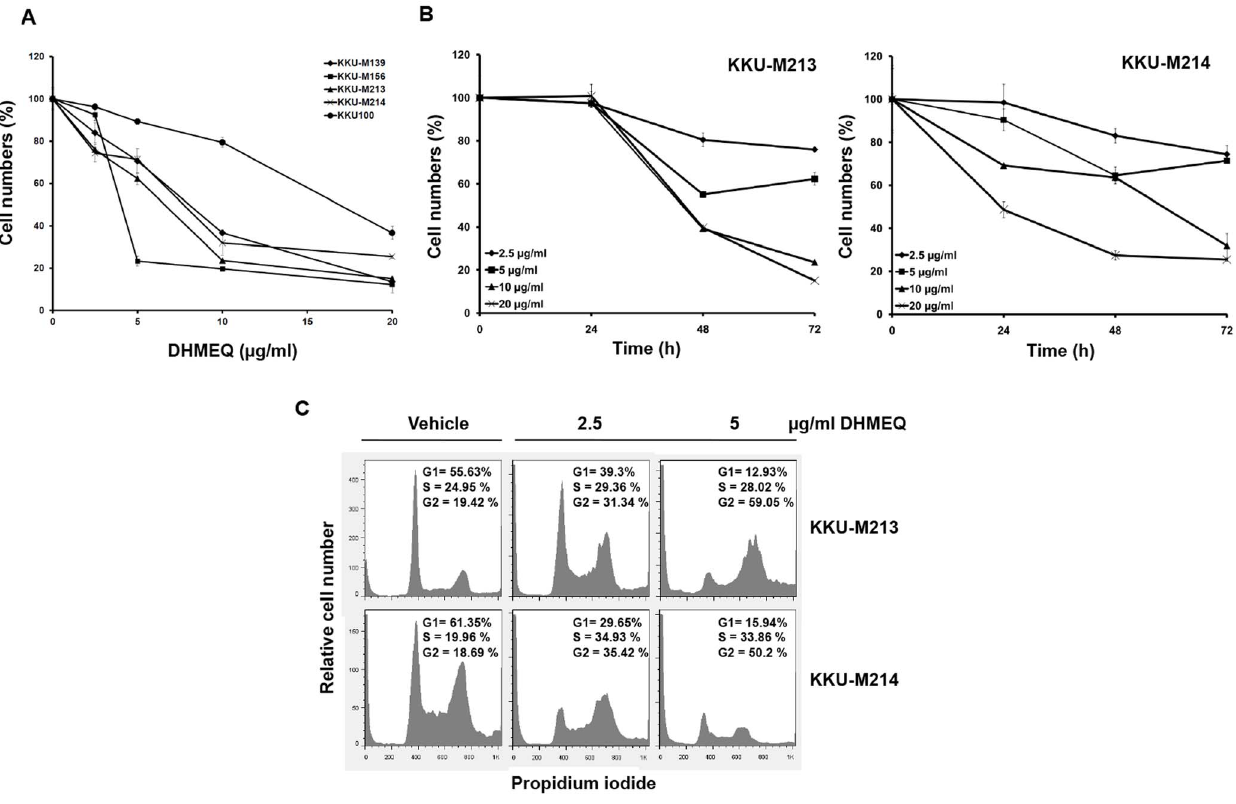
Figure 2. High concentration of DHMEQ caused cell death and low concentration induced G2/M arrest in CCA cell lines. A) DHMEQ could inhibit growth of 5 CCA cell lines as monitored by MTT assay at 72 h. B) DHMEQ suppressed growth of CCA cell lines in a dose and time dependent fashions. C) Growth arrest at G2/M phase was observed in CCA cell lines treated with low concentrations of DHMEQ (2.5 and 5 m g/mL).